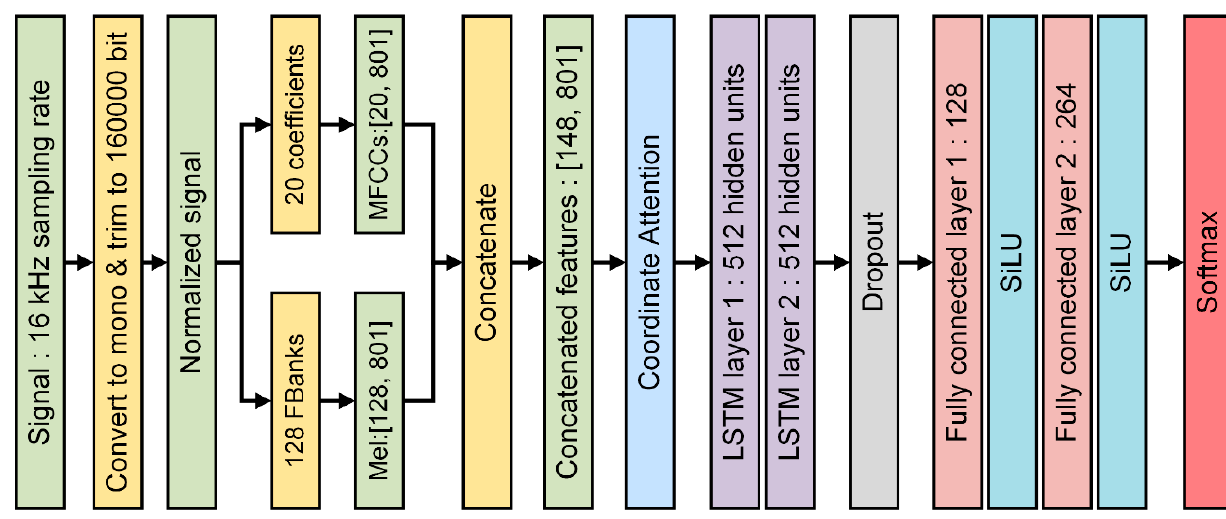
Figure 7. Overview of the proposed deep neural network.